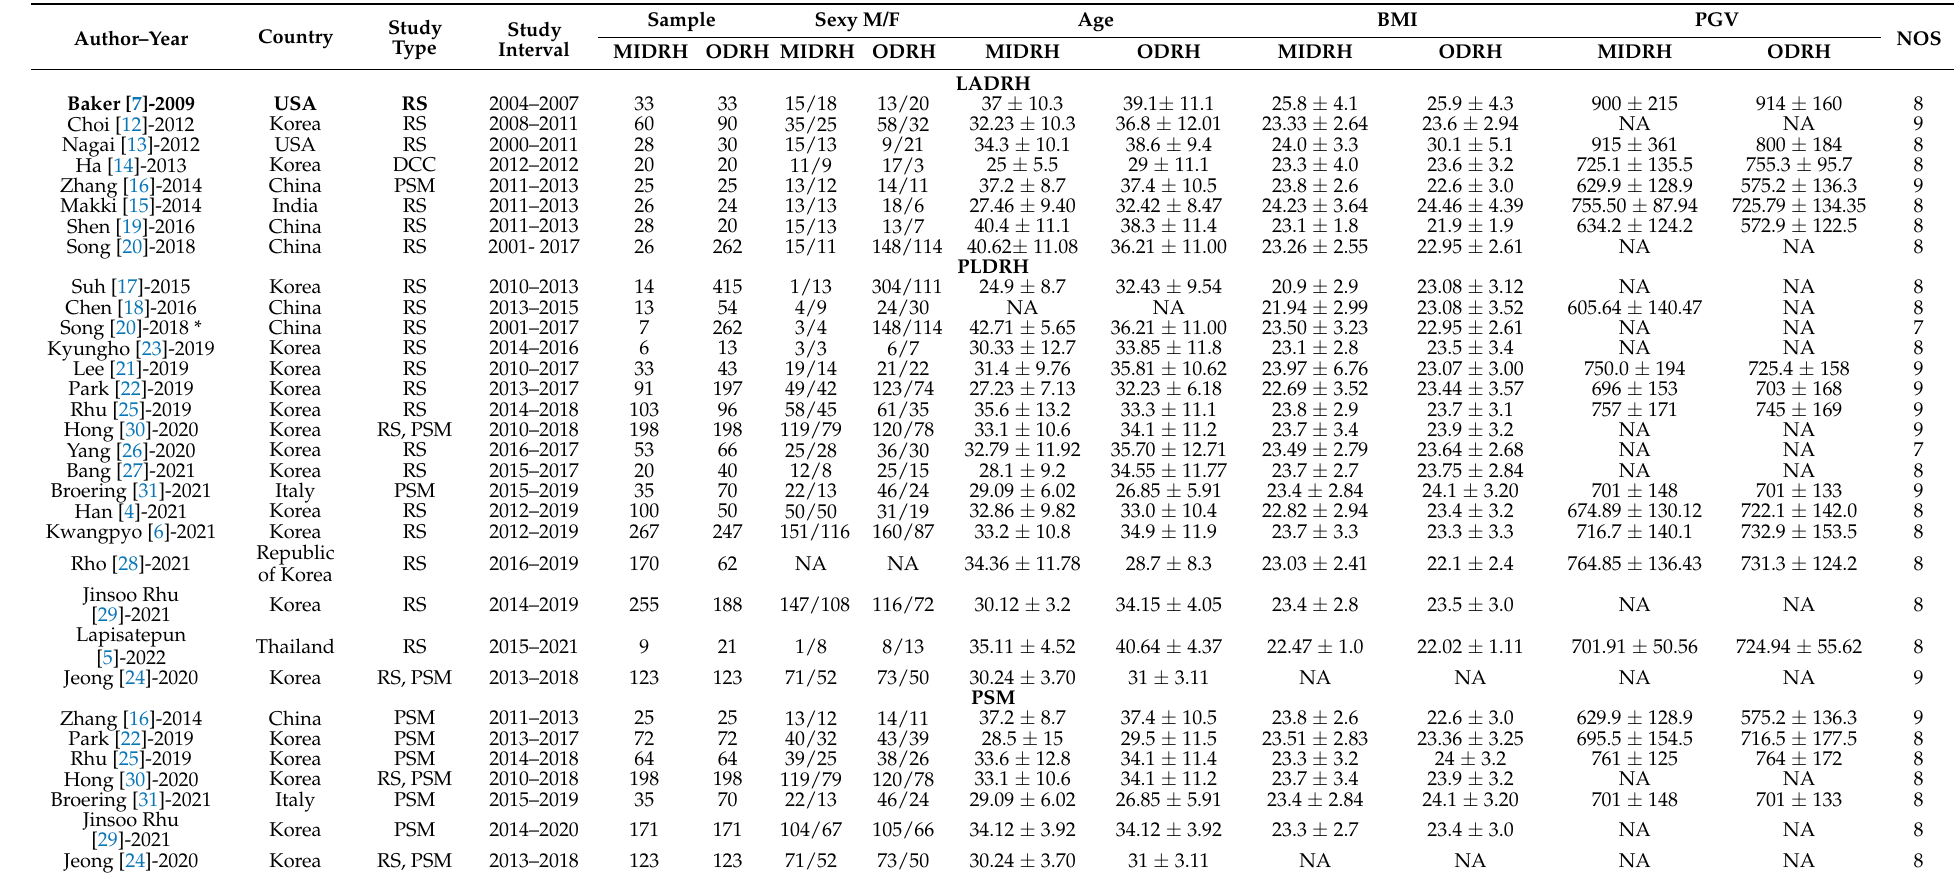
Table 1. Characteristics of Included Studies Comparing MIDRH with ODRH for